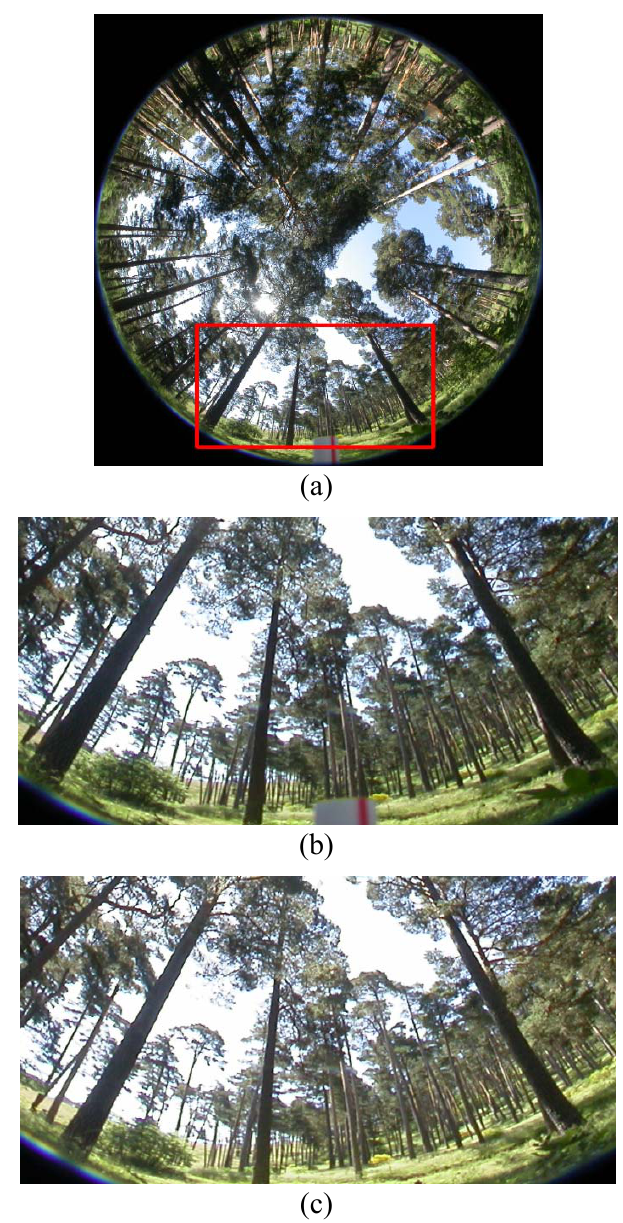
(b) a classification approach based on the combination of two single classifiers, they are the well-known fuzzy clustering strategy [7] and the parametric Bayesian estimator [8]. Figure 1. (a) Hemispherical left image; (b) left expanded area; (c) corresponding right expanded